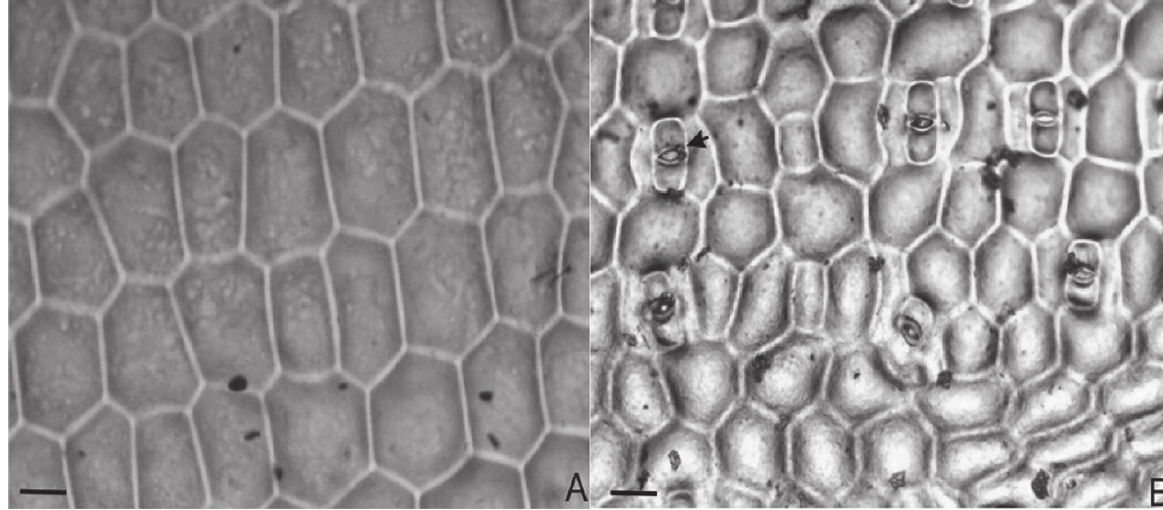
Fig. 1 - Epidermis of Tradescantia . (a) . Adaxial face. (b) . Abaxial face (arrow indicates a stomata). Scale bar = 50